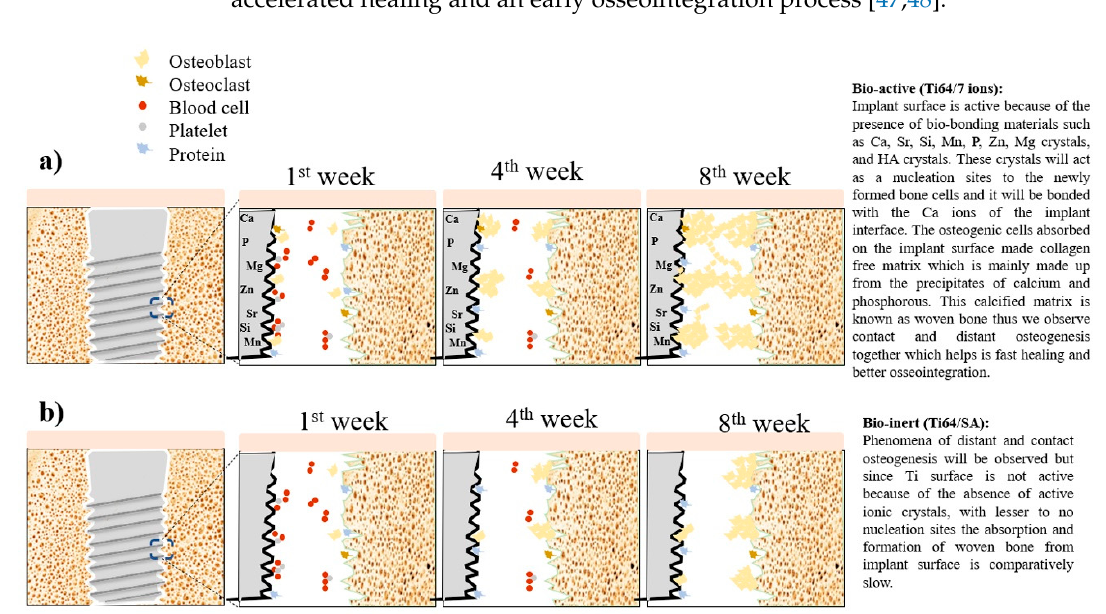
Figure 8. The proposed mechanism for the new bone formation in ( a ) Ti64/7 ion implants and ( b ) Ti64/SA implants.